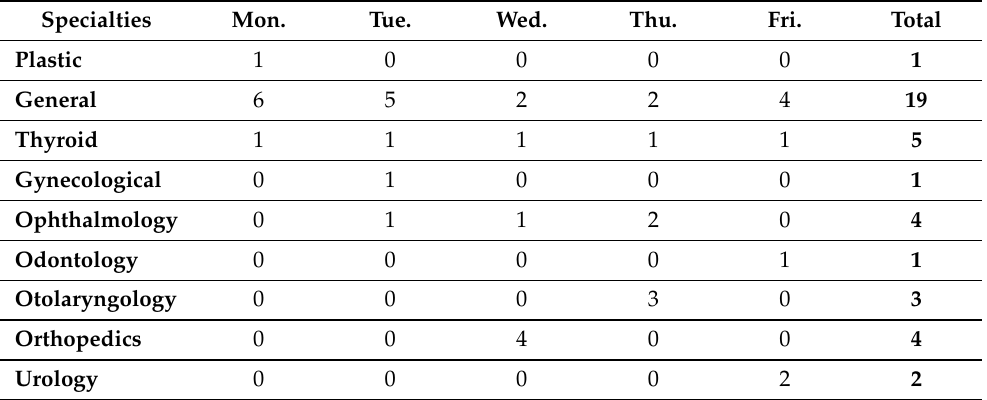
Table 5. New schedule with w 1 = w 2 = 0.5 and c s =